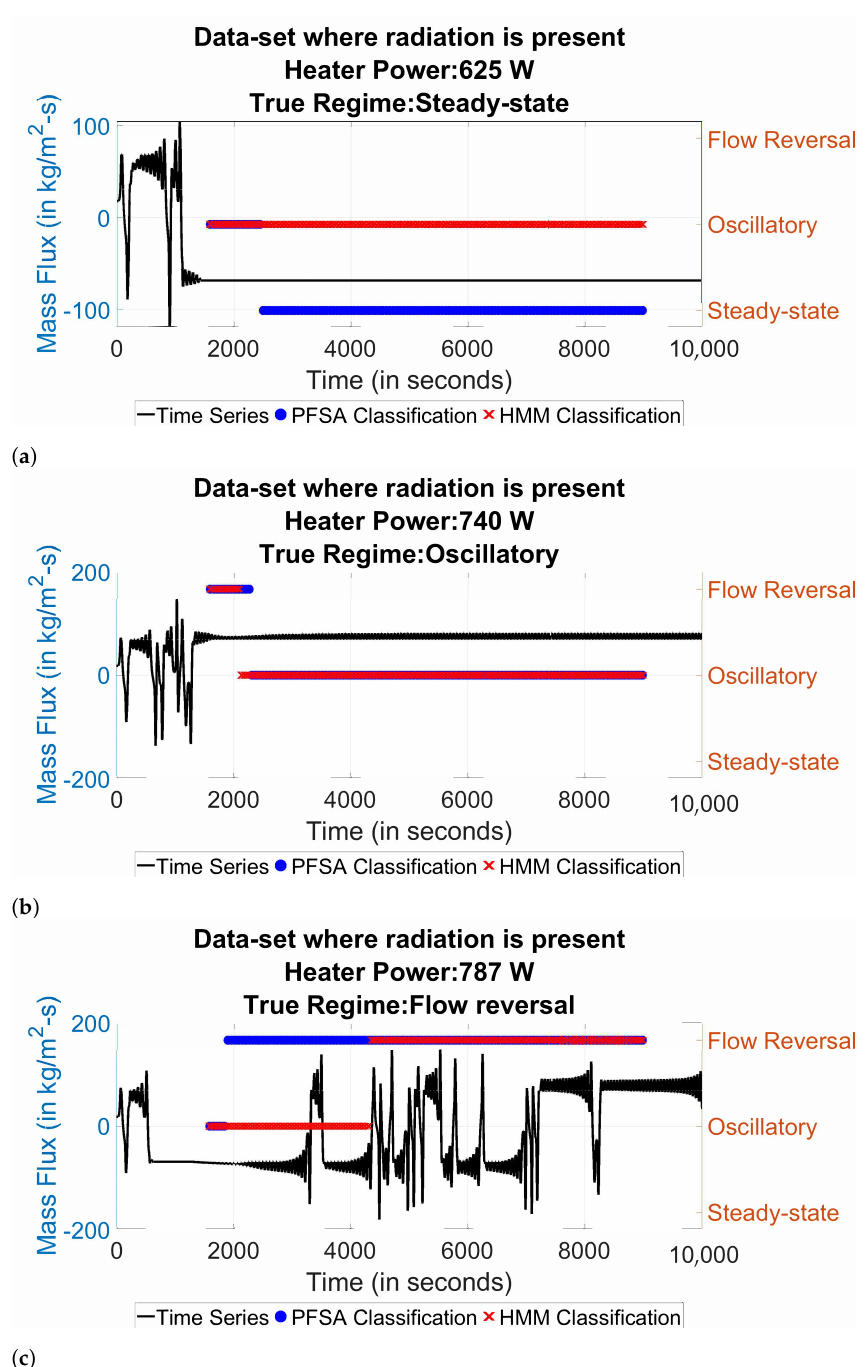
Figure 9. Transient classification for time-series with radiation heat loss using PFSA and HMM for regimes: ( a ) Steady-state, ( b ) Oscillatory, and ( c )